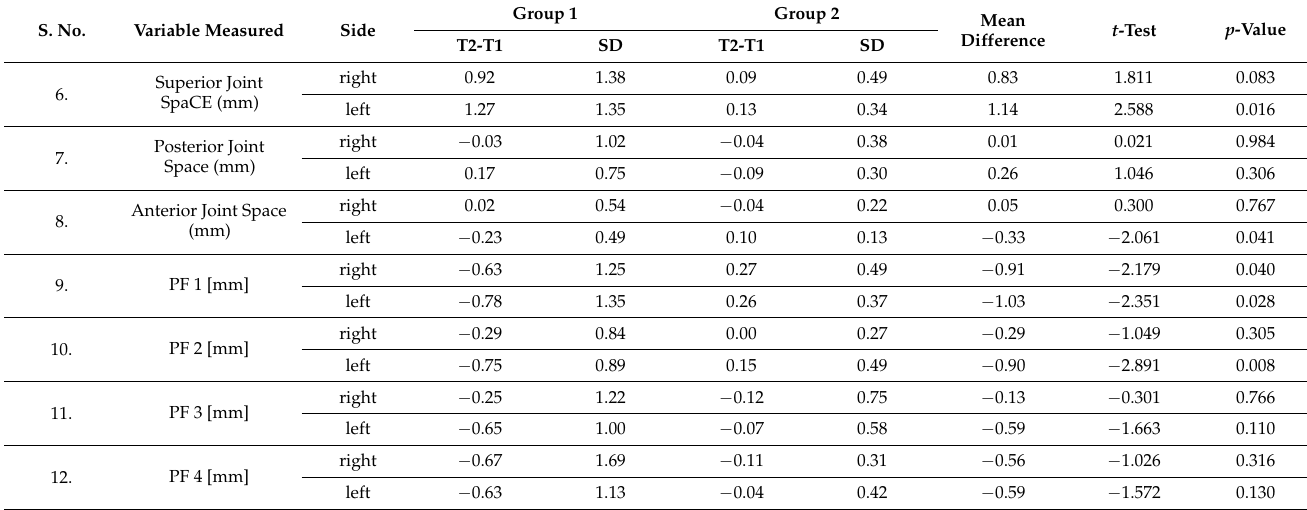
Table 5. Inter-group comparison between Group 1 and Group 2 for effective treatment changes in glenoid fossa. S.